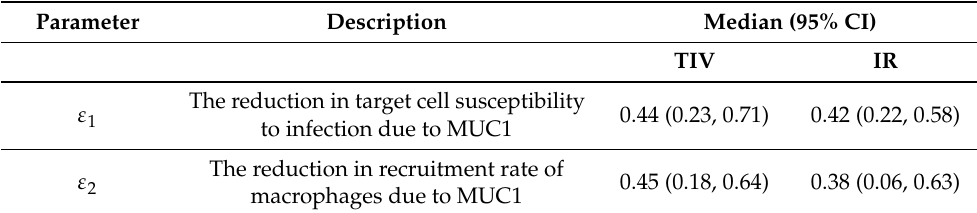
Table 1. Estimates of MUC1 parameters and comparison between models. The estimates of MUC1 on reduction of target cell susceptibility to influenza virus ( ε 1 ) and on reduction of macrophage recruitment rate induced by infected cells ( ε 2 ). The lower and upper boundary of the 95% credible interval (CI) of the parameter is given by calculating the 2.5% and 97.5% quantile of the marginal posterior parameter